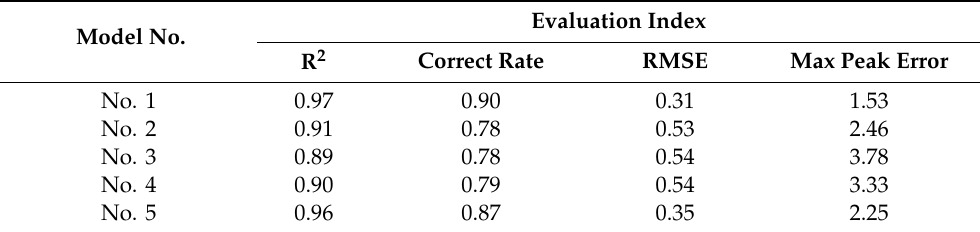
Table 12. Evaluation index value extracted only for results where the stop time of CRAC is less than 10 min. Model No.